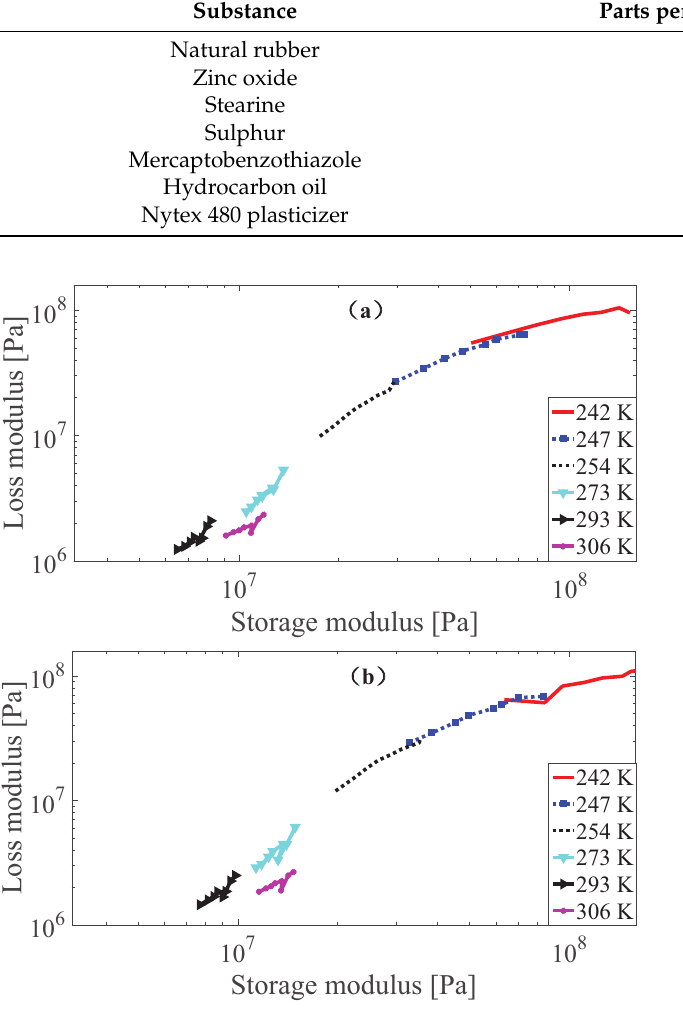
Figure 3. The Cole–Cole plot of dynamic shear modulus at 0.0005 strain amplitude with 0T ( a ) and 0.55T ( b ) under different